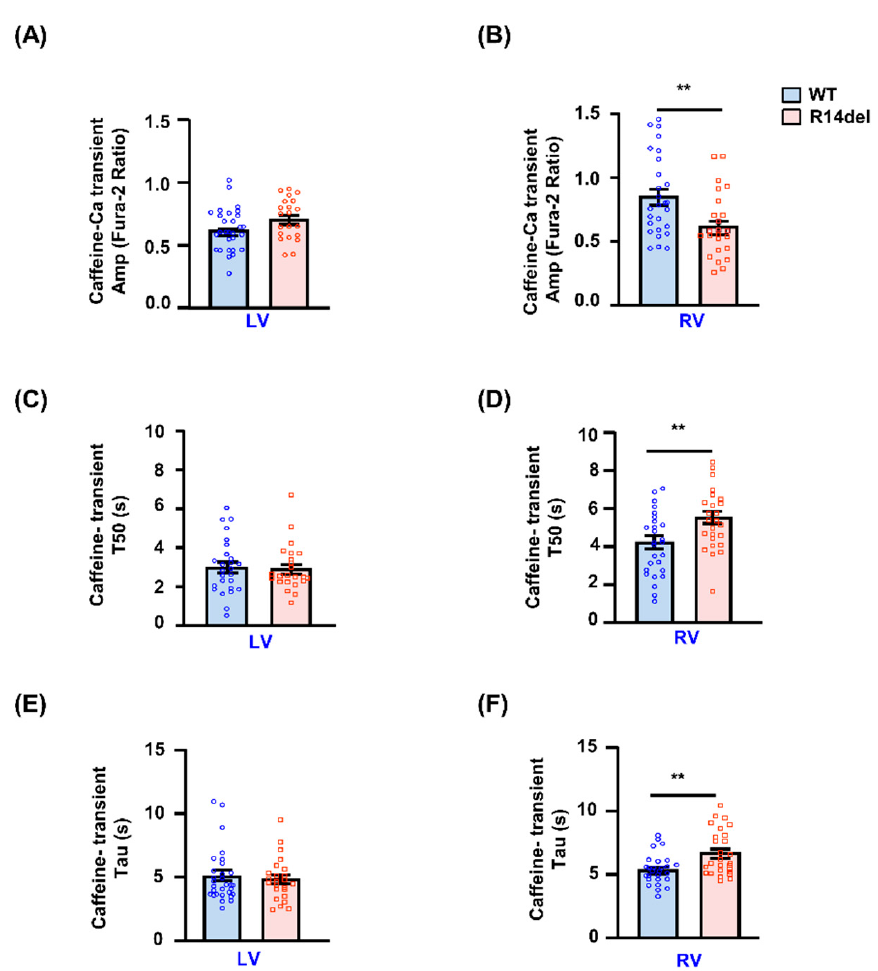
Figure 5. Sarcoplasmic reticulum Ca-load and NCX activity. SR Ca load and NCX function were assessed under caffeine (20 mM/L) application. Caffeine transients were measured in LV and RV cardiomyocytes loaded with the Fura-2 AM fluorescence indicator (2 µ M). ( A , B ) Amplitude of caffeine-induced Ca transients showing SR Ca load in LV and RV myocytes, as indicated by the fura-2 ratio (340:380 nm). ( C , D ) T50: the time constant for 50% decay of the caffeine-induced Ca transient. ( E , F ) Tau of caffeine-induced Ca transient decay. n = 27 LV and 28 RV cells for WT (N = 3 hearts); n = 27 LV and 29 RV cells for R14del-PLN (N = 4 hearts). Data are expressed as mean ± SEM for the number of cells, and statistical analyses were performed by Student’s unpaired t -test. ** p ≤ 0.001 vs. WT-PLN.